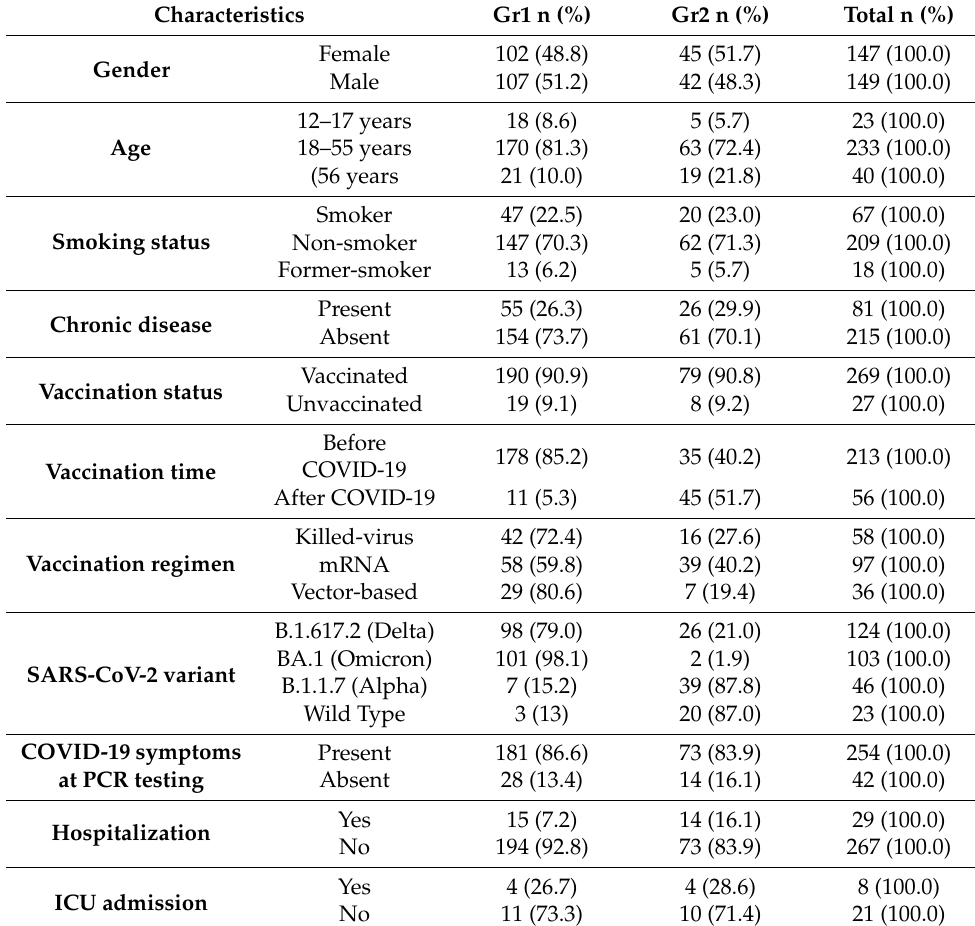
Table 1. Demographic characteristics and clinical profile of the participants.